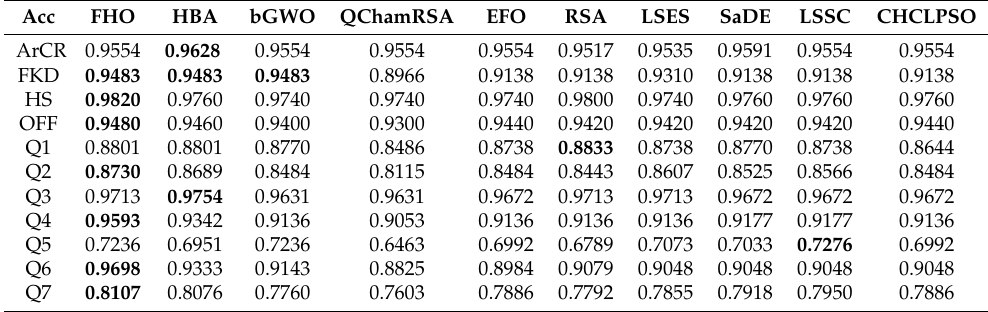
Table 4. Accuracy results obtained by FHO and other methods in the binary case. Acc FHO HBA